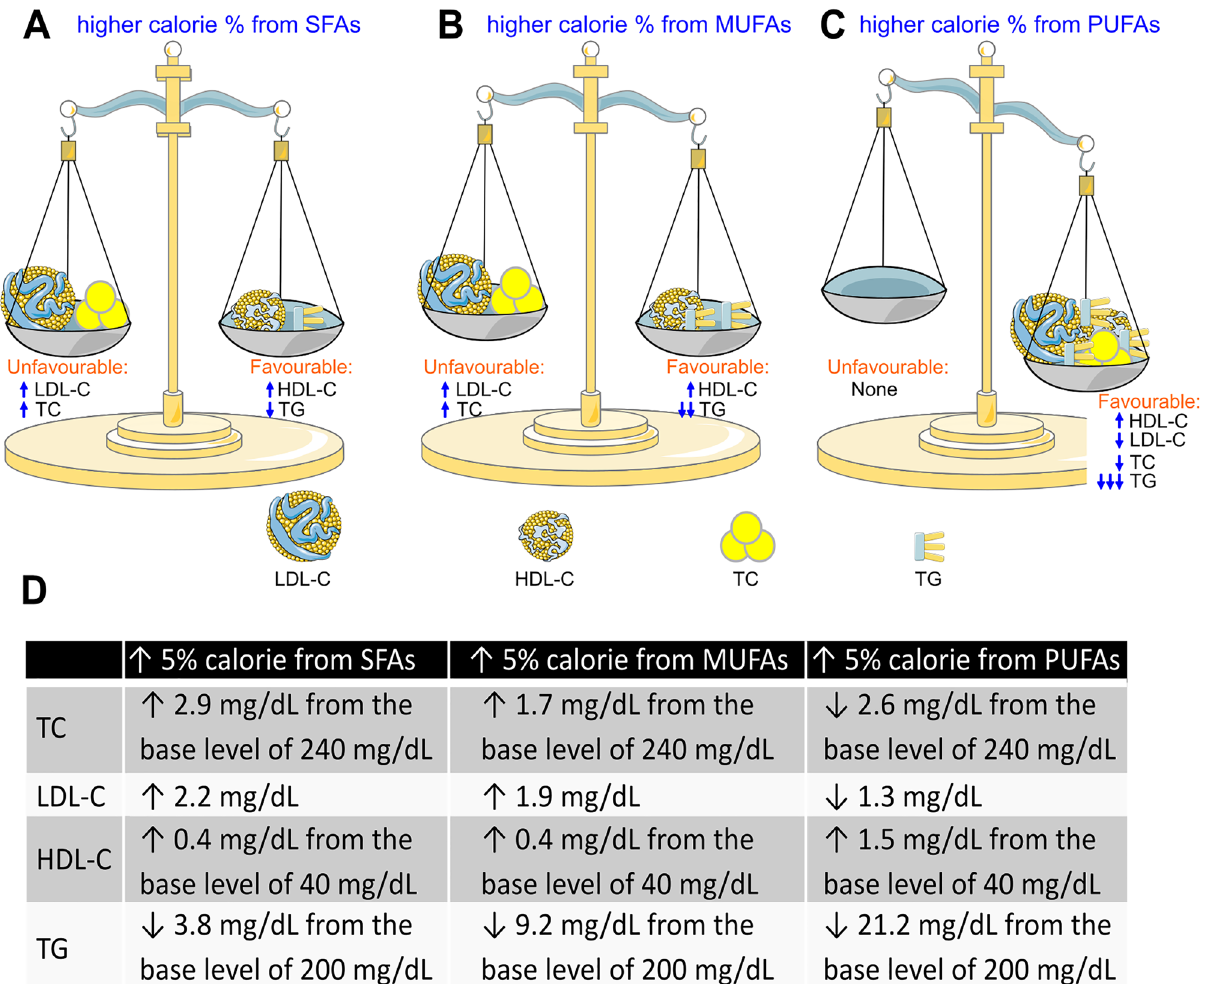
Figure 1. Lipid profile associated with usual intake of fatty acids in 44,279 adults without a prior diagnosis of myocardial infarction. ( A-B) , Higher usual intake of saturated fatty acids (SFAs, A ) and monounsaturated fatty acids (MUFAs, B ) was associated with higher low-density lipoprotein cholesterol (LDL-C), higher total cholesterol (TC), higher high-density lipoprotein cholesterol (HDL-C) and lower triglyceride (TG). ( C ), Higher usual intake of polyunsaturated fatty acids (PUFAs) was associated with higher HDL-C, lower LDL-C, lower TC, and lower TG. ( D ) The extent of change in lipid profile associated with a 5% higher calorie intake from fatty acids. This figure was partly generated using Servier Medical Art, provided by Servier, licensed under a Creative Commons Attribution 3.0 unported license.